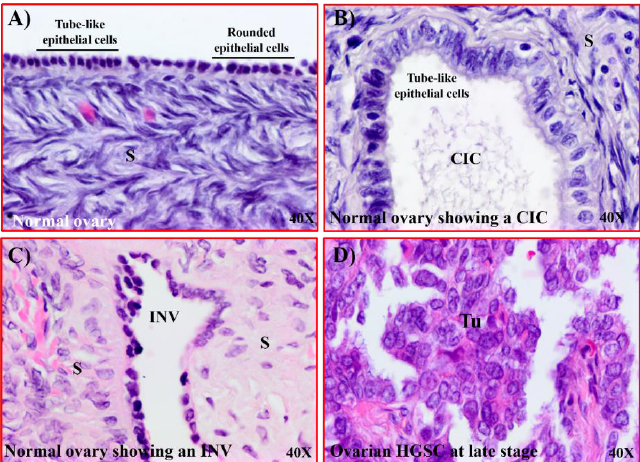
Figure 3. Microscopic features in ovaries with a risk of OVCA development. Sections were examined with H&E staining. ( A ) Section of a normal ovary showing both rounded and tube-like surface epithelial cells. ( B ) Section of a normal ovary showing a cortical inclusion cyst (CIC) embedded in the stroma containing a single layer of tube-like epithelial cells. ( C ) Section of a normal ovary showing a stromal invagination (INV) formed along the normal ovarian surface epithelium. ( D ) Section of an ovarian HGSC showing papillary structures and malignant cells containing pleomorphic nuclei. S = stroma, Tu = tumor. Magnification = 40X.